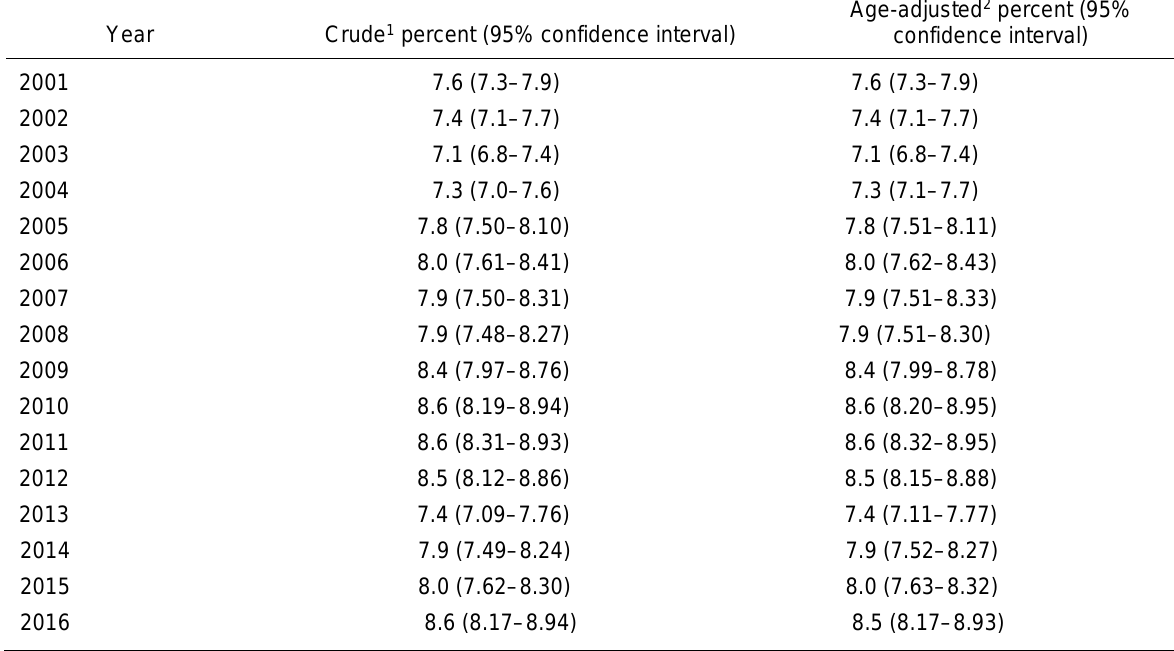
Data table for Figure 15.4. Prevalence of current asthma among persons of